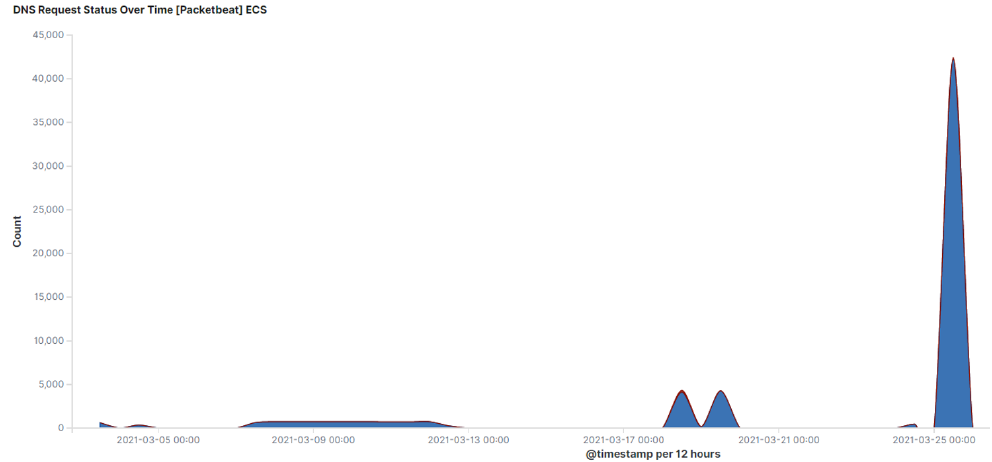
Figure 14. DNS traffic request volume over time.